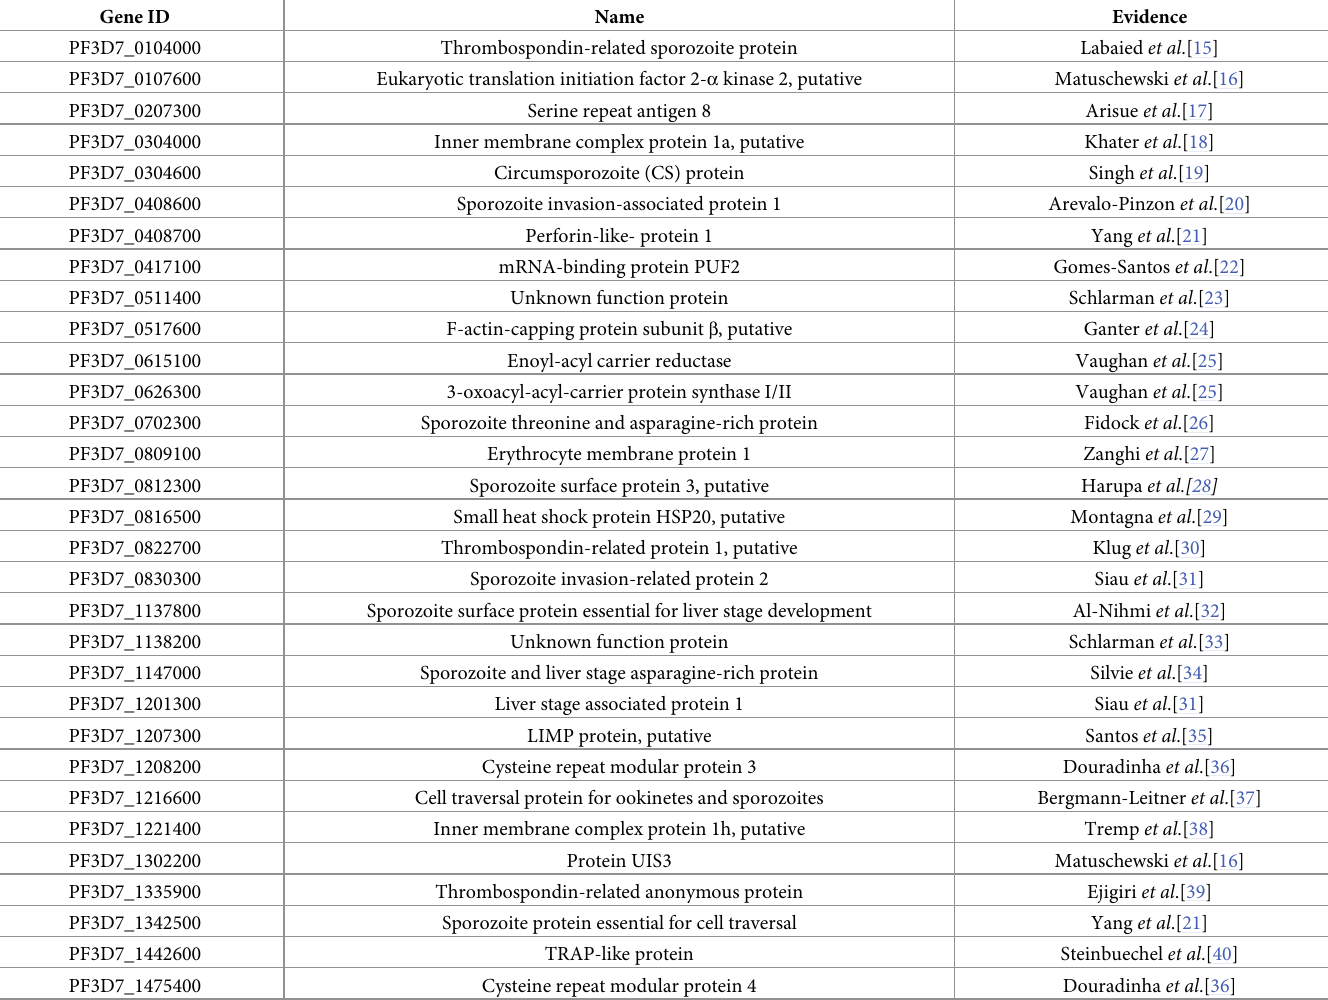
Table 1. Positive gold standard members, based on the presence of proteins in western blot or immunofluorescent assay data. Gene